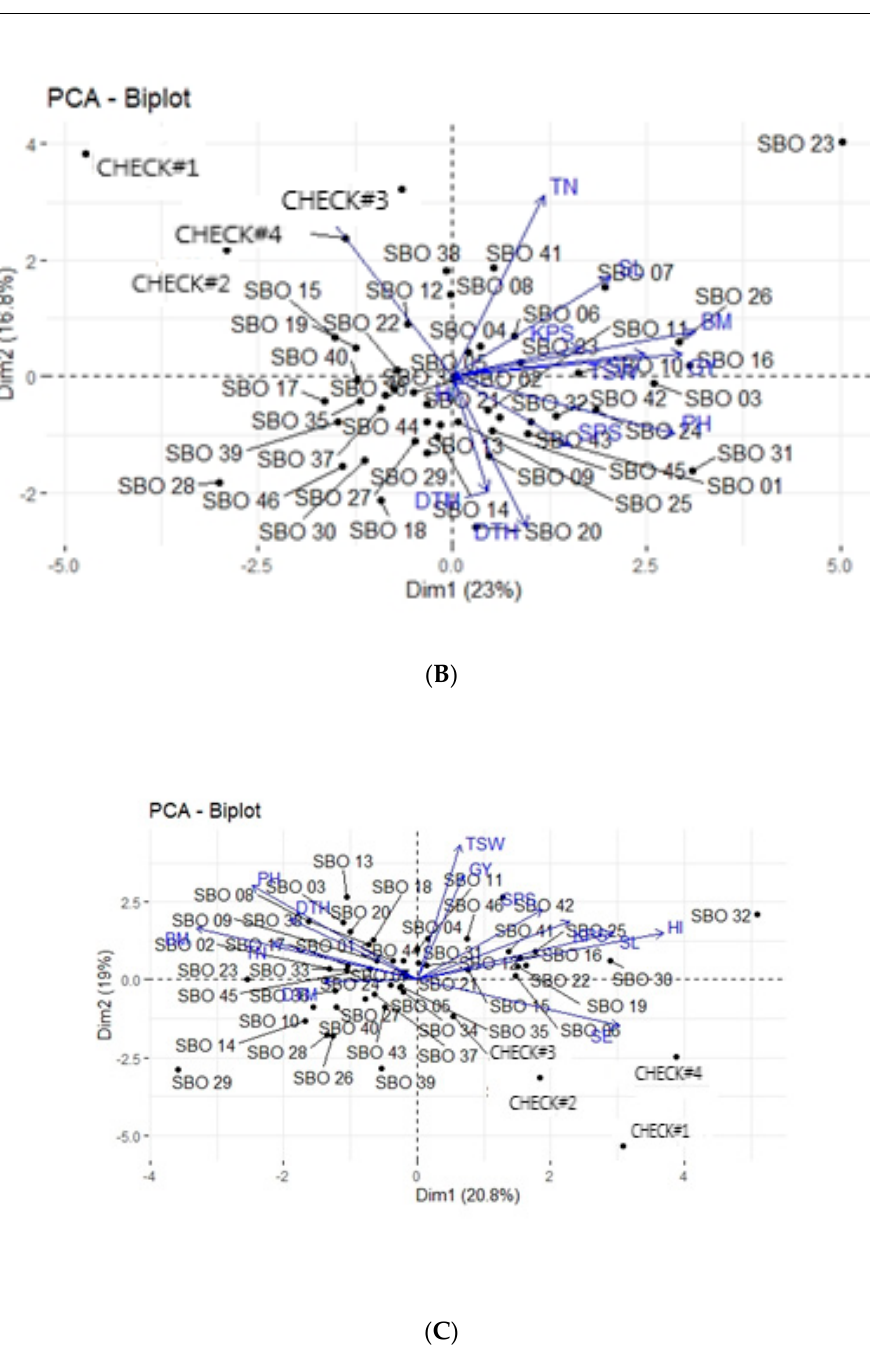
Figure 2. Principal component biplot showing genotypic grouping under non-stressed conditions and at three nitrogen levels (( A ), 50 kg ha − 1 ; ( B ), 100 kg ha − 1 and ( C ), 200 kg ha − 1 ). SE, number of seedlings emerged; DTH, days to 50% heading; DTM, days to maturity; PH, plant height (cm); TN, number of productive tillers; SL, spike length (cm); SPS, number of spikelets per spike; KPS, number of kennels per spike; TSW, thousand seed weight (g/1000 seed); GY, gain yield (g/m 2 ); BM, biomass (g/m 2 ); HI, harvest index. See codes of genotypes in Table 1.